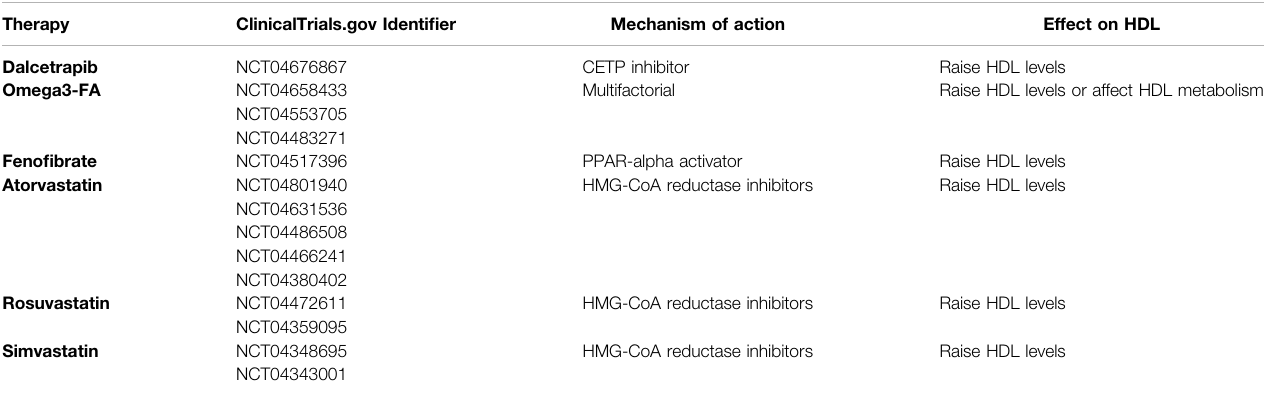
TABLE 2 | Clinical studies about drugs that affect HDL on patients with COVID-19.